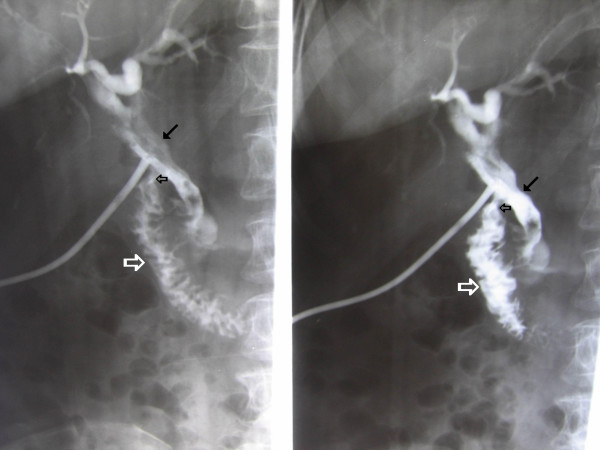
The post-operative T- tube cholangiography. It is demonstrating a fistula (open black arrow) located between the CBD (solid arrow) and the duodenum (open white arrow).